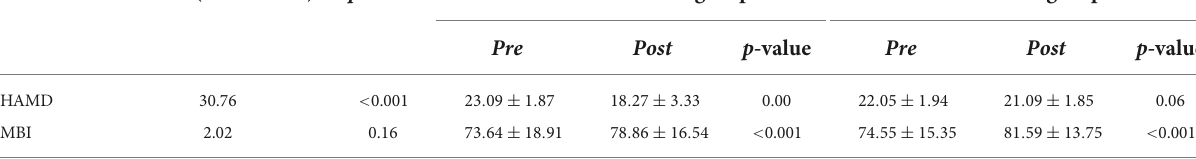
TABLE 2 Pre and post outcome measures of the immersive-VR group and the control